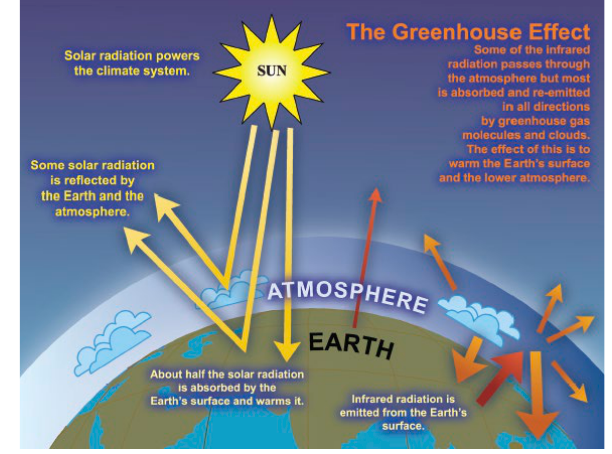
Figure 1. Schematic representation of the Earth’s climate system and the greenhouse effect (from Le Treut et al.,